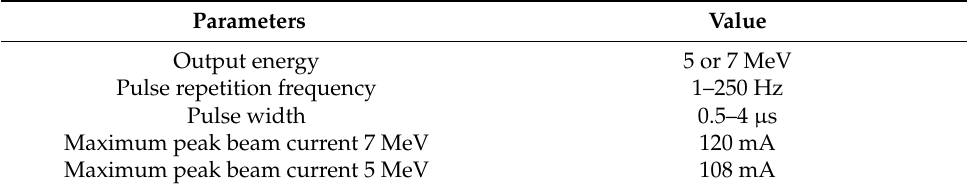
Table 1. Main features of